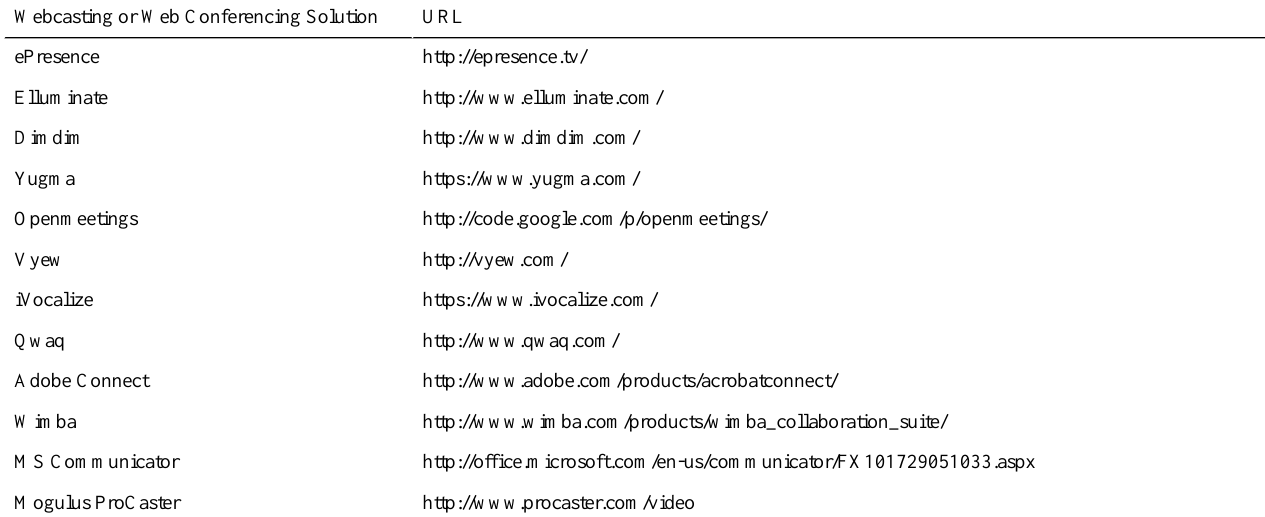
Table 3. Examples of current interactive webcasting and Web conferencing solutions for e-learning URLWebcasting or Web Conferencing